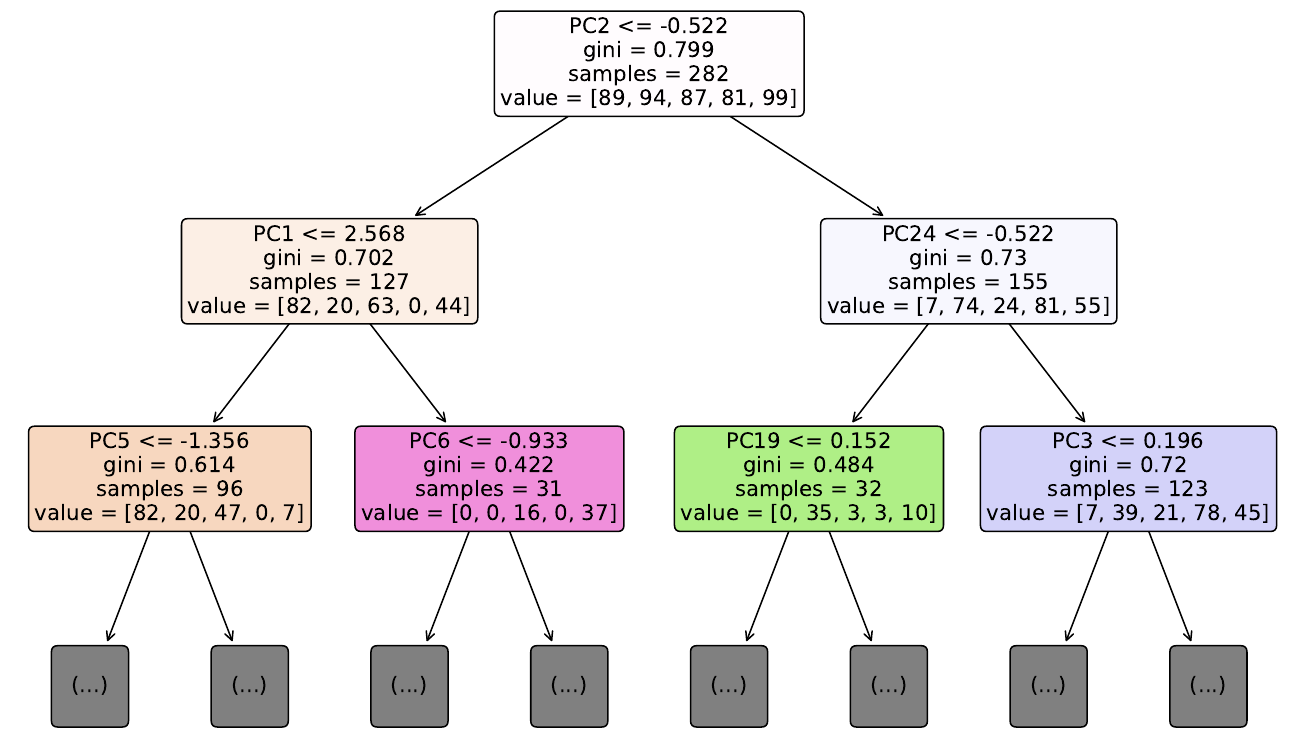
Figure 8. Three initial levels of one of the randomly generated decision trees making up the RF classifier. The five elements of value in each node correspond to splitting the sample data into five classes. PCn denotes the n -th PCA component